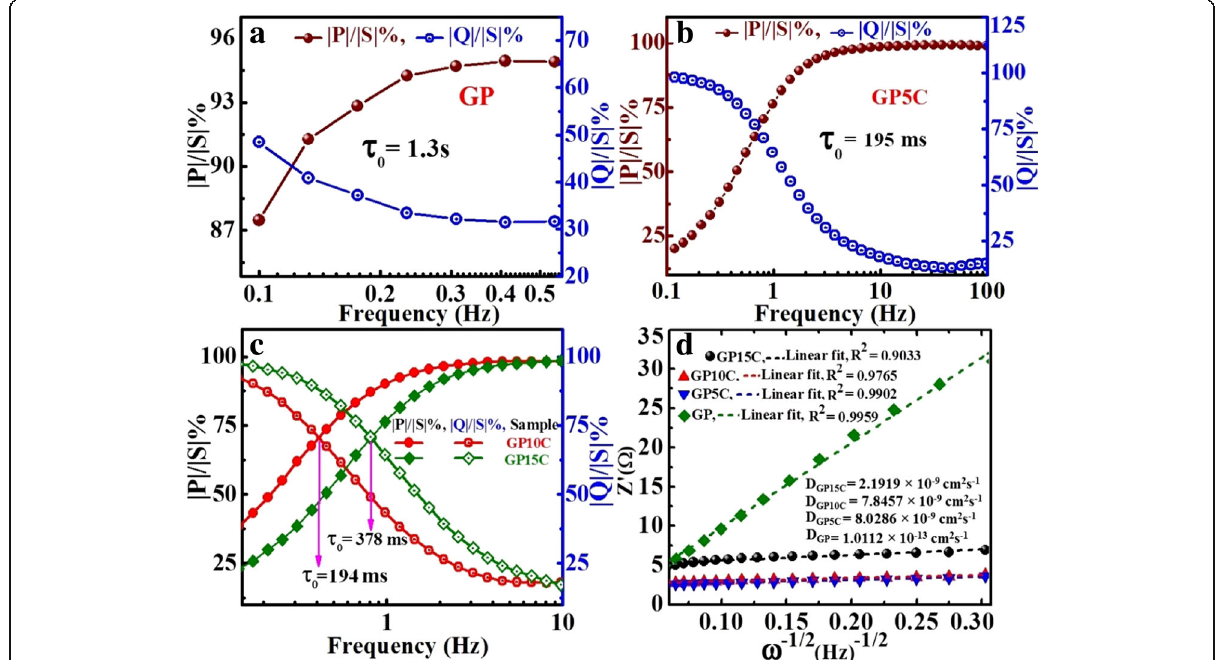
Fig. 9 a – c are the normalized real part |P|/|S| and imaginary part |Q|/|S| of the complex power as a function of frequency for GP, GP5C, and GP10C, respectively, and d Randles plots of all the synthesized electrodes